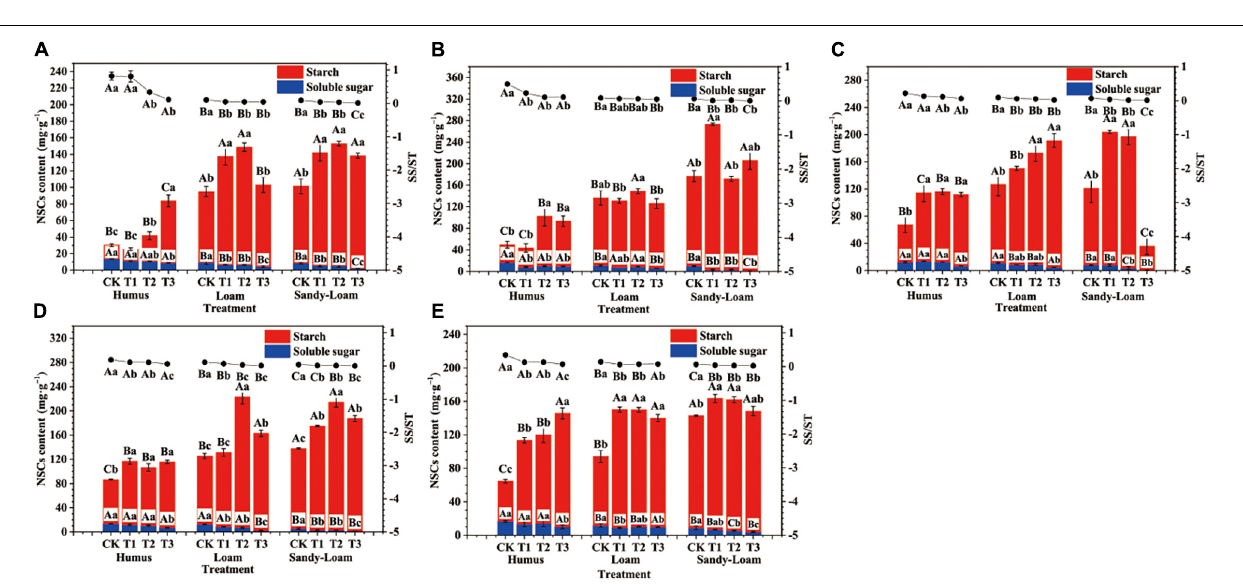
FIGURE 4 | The fine root non-structural carbohydrate (NSC) content of Fraxinus mandshurica seedlings in different drought intensities and soil substrates. The histogram represents the soluble sugar (SS) and starch (ST) content, and the line chart represents the SS-ST ratio (SS/ST). The different lowercase letters denote significant differences among soil substrates ( p < 0.05). The different uppercase letters denote significant differences among drought intensities ( p < 0.05). (A) 1st-order root; (B) 2nd-order root; (C) 3rd-order root; (D) 4th-order root; (E) 5th-order root. CK: control; T1: mild drought; T2: moderate drought; T3: severe